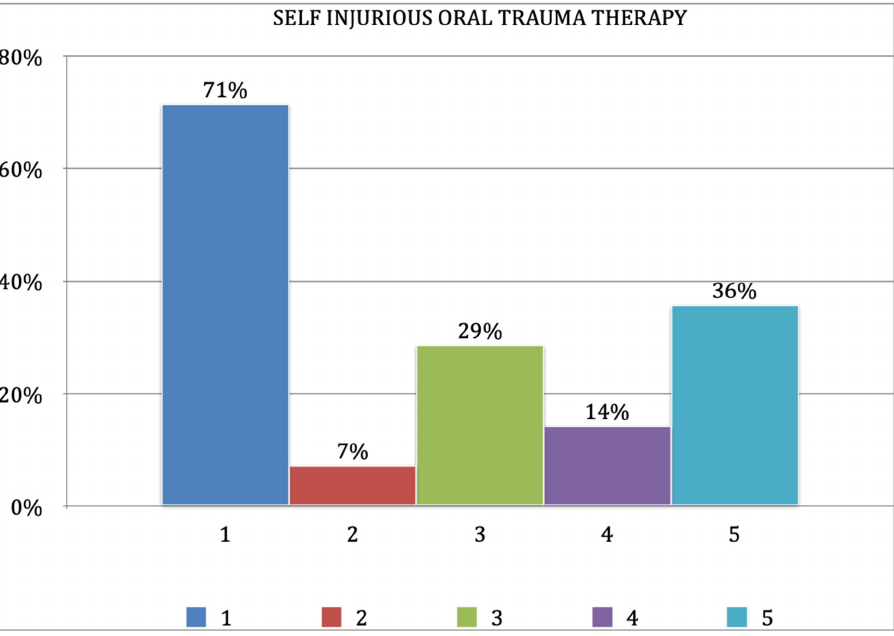
Figure 2. Incidence of the various forms of therapeutic approach. 1: tooth extraction; 2: drugs; 3: orthodontic appliances; 4: dental re ‐ contouring; 5: obstructive methods.